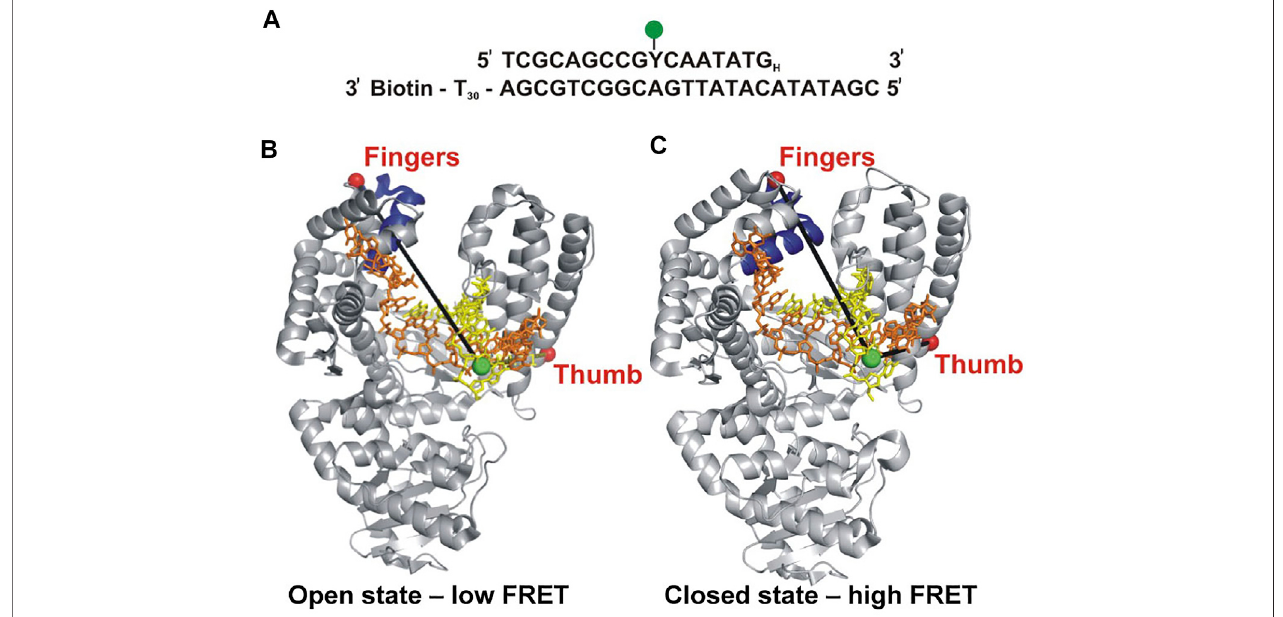
FIGURE 1 | Labeling strategy used to probe the fi ngers-closure transition in KF. (A) Sequence of the primer/template. Y denotes the labeling site for A488 (green) and the H subscript at the 3 ′ end of the primer denotes a dideoxy modi fi cation. The biotin moiety on the template strand is used for surface attachment. (B) Crystal structure of the KF homolog Bst Pol I in open conformation (PDB code 1L3S). Primer strand is yellow and template strand is orange. (C) Crystal structure of Bst Pol I in closed conformation (PDB code 1LV5). In both (B,C) , the A488 donor is shown as a green sphere and the A594 acceptor attached to the fi ngers domain as a red sphere. The donor-acceptor distance (black lines) is shorter in the closed conformation than in the open conformation, leading to higher FRET ef fi ciency. For some experiments (not described here), A594 was attached to the thumb domain. Reproduced from reference (Berezhna et al., 2012) with